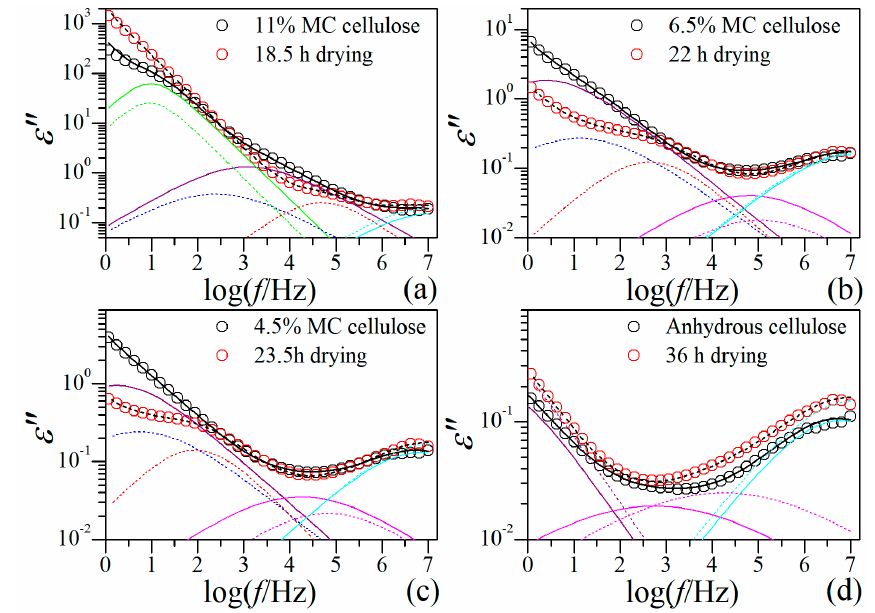
Figure 6. Comparison on the dielectric relaxation behavior between native cellulose with different moisture content and regenerated cellulose film at different drying moments.